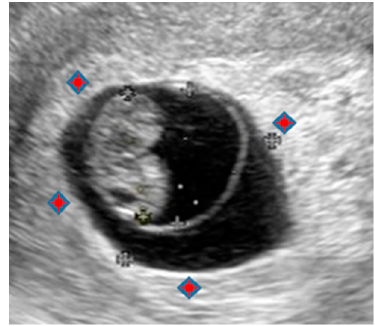
Figure 3. Ultrasonographic image at 7 w 3 d (19.3 × 13.8 mm). The red marks show the lacunar space where AE is injected.